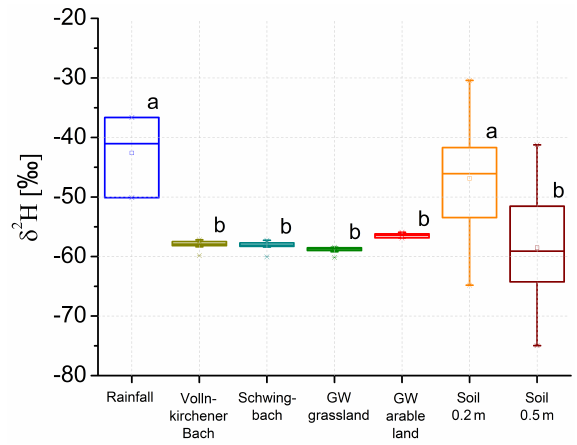
Figure 4. Box plots of δ 2 H values comparing precipitation, stream, groundwater, and soil isotopic composition at 0.2 and 0.5m depth ( N = 52 per depth). Different letters indicate significant differences ( p ≤